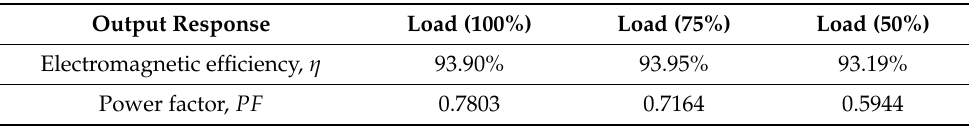
Table 14. Comparison of electromagnetic efficiency and power factor for various load points of the optimal design–multivariate optimization problem.